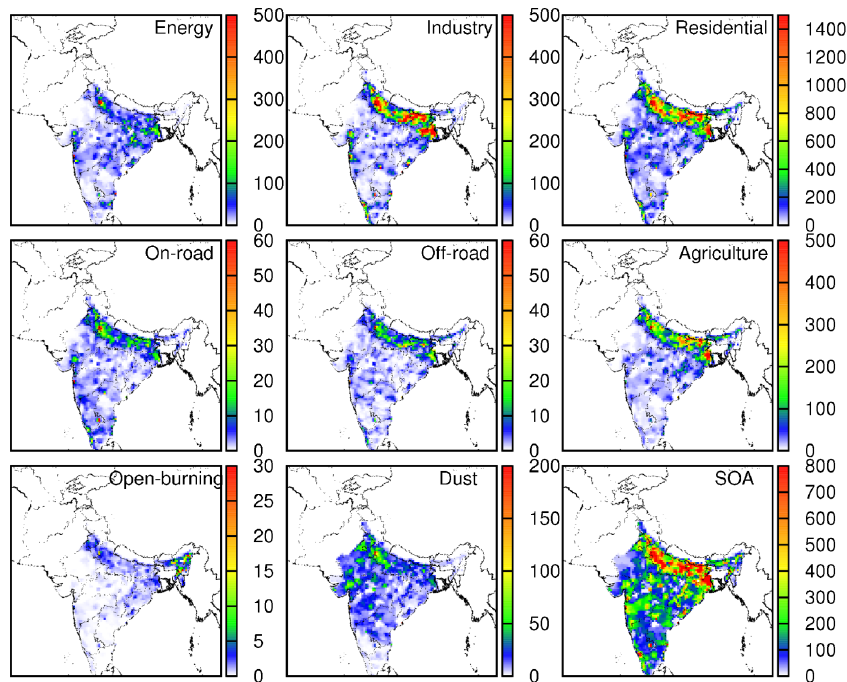
Figure 4. Source contributions to total premature mortality (deaths per grid 36 × 36km) due to COPD, LC, IHD, and